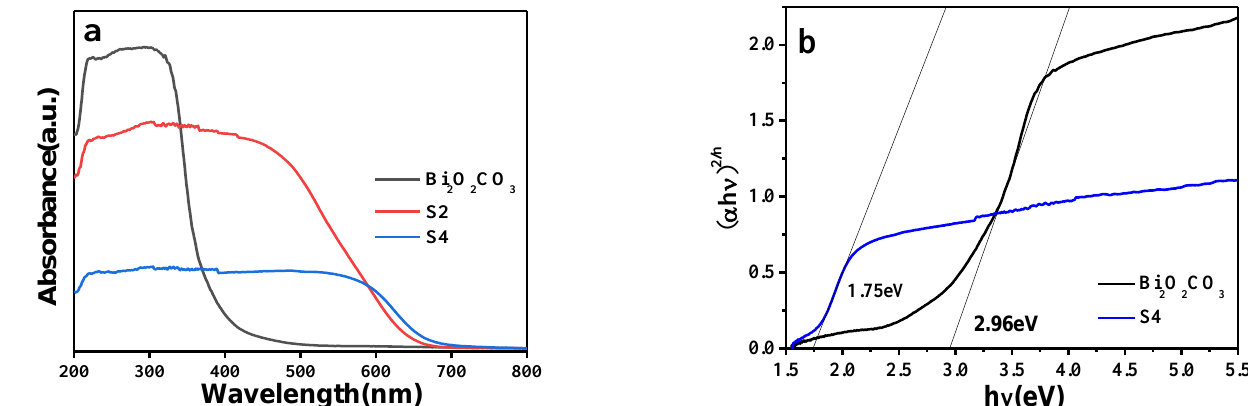
Figure 5. ( a ) UV-Vis diffuse reflectance spectra of Bi 2 O 2 CO 3 , S2 heterostructures and S4 (pure BiOI) and ( b ) the plots of (αhν) 2/n vs. hν ( n = 4 for Bi 2 O 2 CO 3 and BiOI).